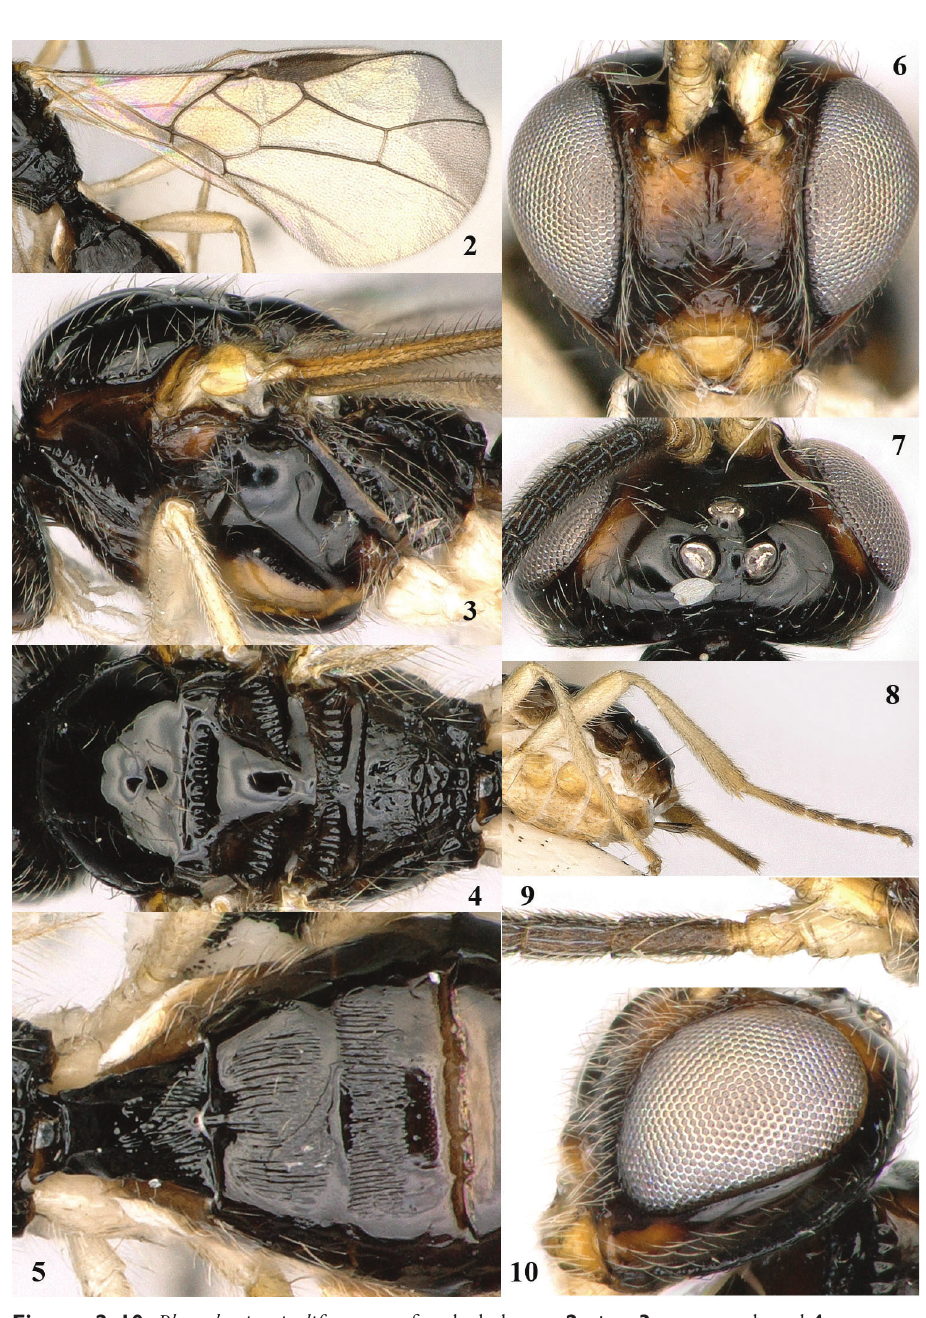
Figures 2–10. Rhogadopsis aciculifera sp. n., female, holotype. 2 wings 3 mesosoma lateral 4 mesosoma dorsal 5 first-third metasomal tergites dorsal 6 head anterior 7 head dorsal 8 hind leg 9 base of antenna 10 head